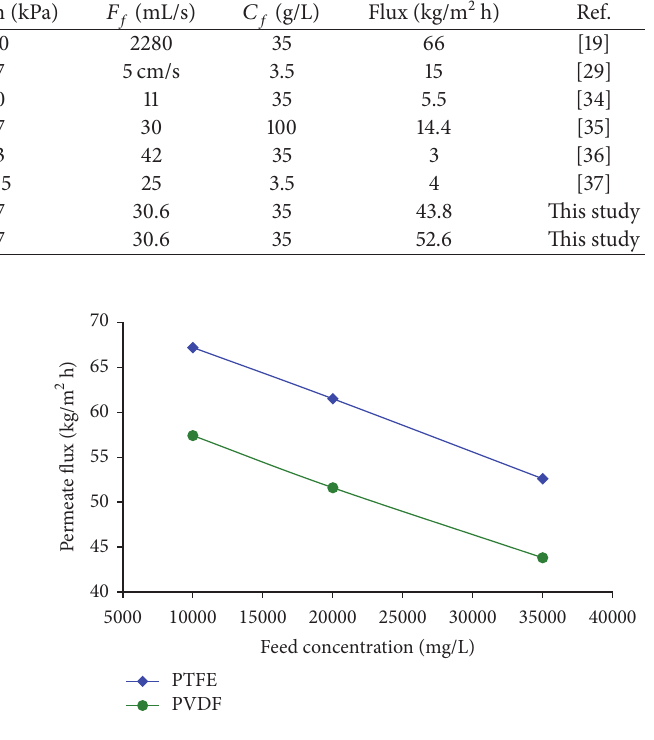
Figure 13: The effect of the feed concentration of NaCl on the permeate flux for PTFE and PVDF membranes at a 65 ∘ C feed temperature, 110.2 (L/h) feed flow rate, and 97 kPa vacuum